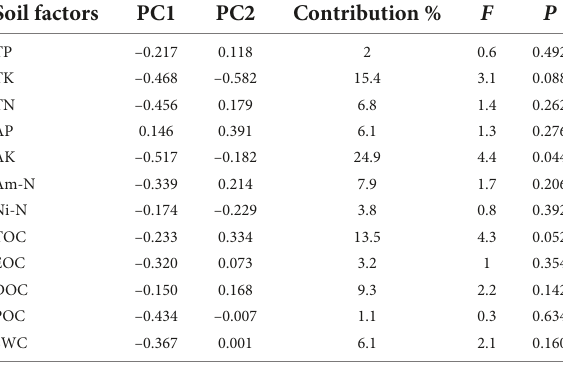
FIGURE5 Redundancy analysis of the association of soil factors with 9 functional traits. These two axes illustrate the two principal components of the multiple linear regression residuals from x to y. Red arrows indicate environmental factors and blue arrows indicate functional traits. The intersection angle between the vector lines represents the correlation between the corresponding variables, where an acute angle indicates a positive correlation, an obtuse angle indicates a negative correlation, and a right angle indicates no correlation. SWC, Soil water content; TOC, Total organic carbon; TN, Total nitrogen; TP, Total phosphorus; TK, Total potassium; AK, available potassium; AP, Available phosphorus; Ni-N, NO 3 − –N, Nitrate nitrogen; Am-N, NH 4 + –N, Ammonium nitrogen; POC, Particulate organic carbon; EOC, Easily oxidized organic carbon; DOC, Dissolved organic carbon.